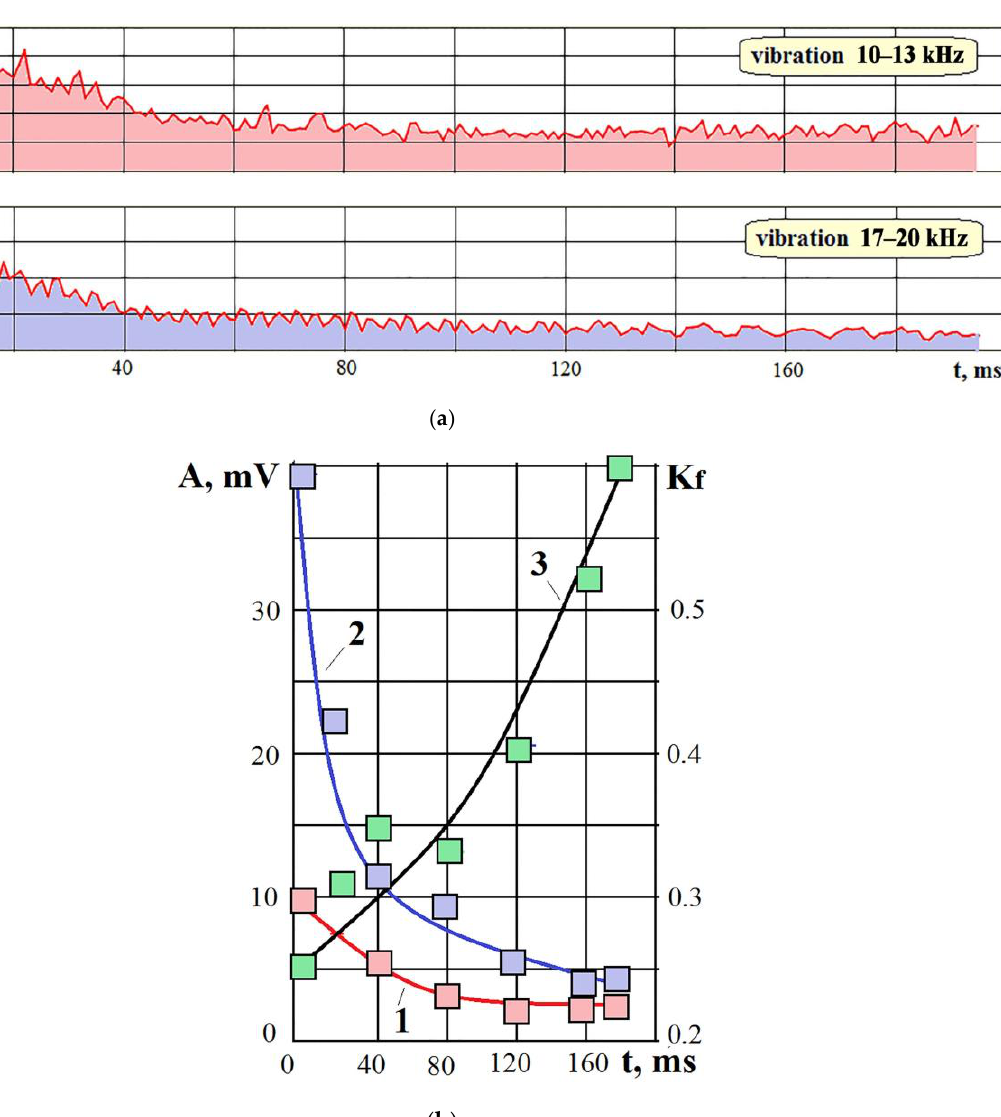
Figure 16. Change of RMS amplitudes of AE signals in two frequency ranges when laser pulses are applied to one point: ( a ) — recordings of RMS amplitudes in the ranges of 10 – 13 kHz and 17 – 20 kHz; ( b ) — graphs of AE parameter changes during pulse exposure (1 — AE in the range of 10 – 13 kHz; 2 — AE in the range of 17 – 20 kHz; 3 — change in the ratio of amplitudes K f ).